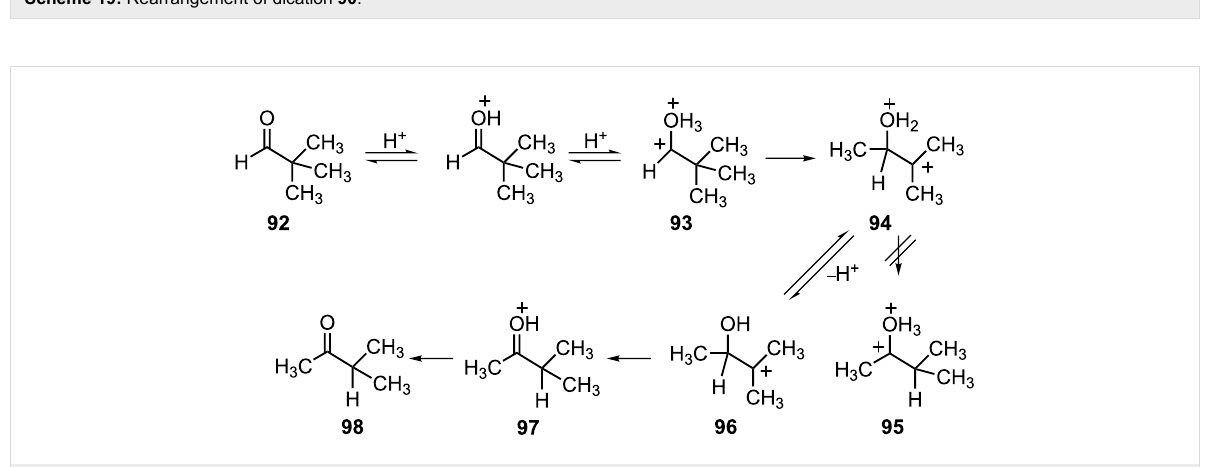
Scheme 20: Superacid promoted rearrangement of pivaldehyde ( 92